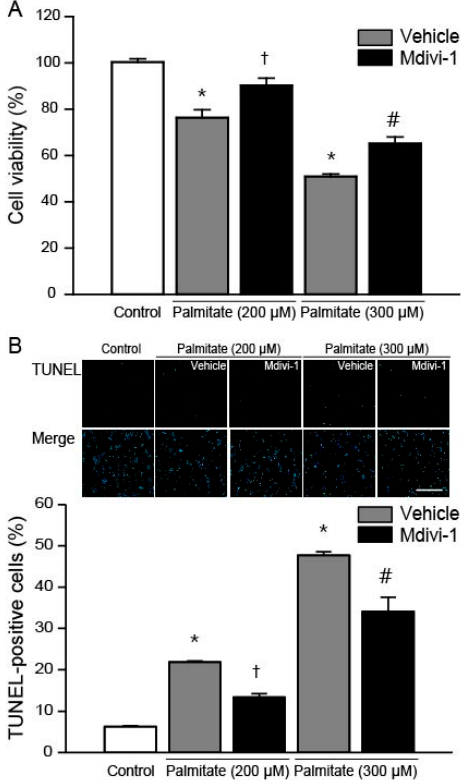
Figure 1. Mdivi-1 protects hippocampal NSCs against palmitate insult. Cells were pretreated with dimethyl sulfoxide (DMSO) vehicle or mdivi-1 (20 μ M) for 2 h and then exposed to 0.5% bovine serum albumin (BSA) vehicle or palmitate (200 and 300 μ M) for 24 h. ( A ) Cell viability was measured by the 3-(4,5-dimethylthiazol-2-yl)-2,5-diphenyltetrazolium bromide (MTT) assay. ( B ) Apoptosis was assessed by terminal deoxynucleotidyl transferase dUTP nick end labeling (TUNEL) staining. Nuclei